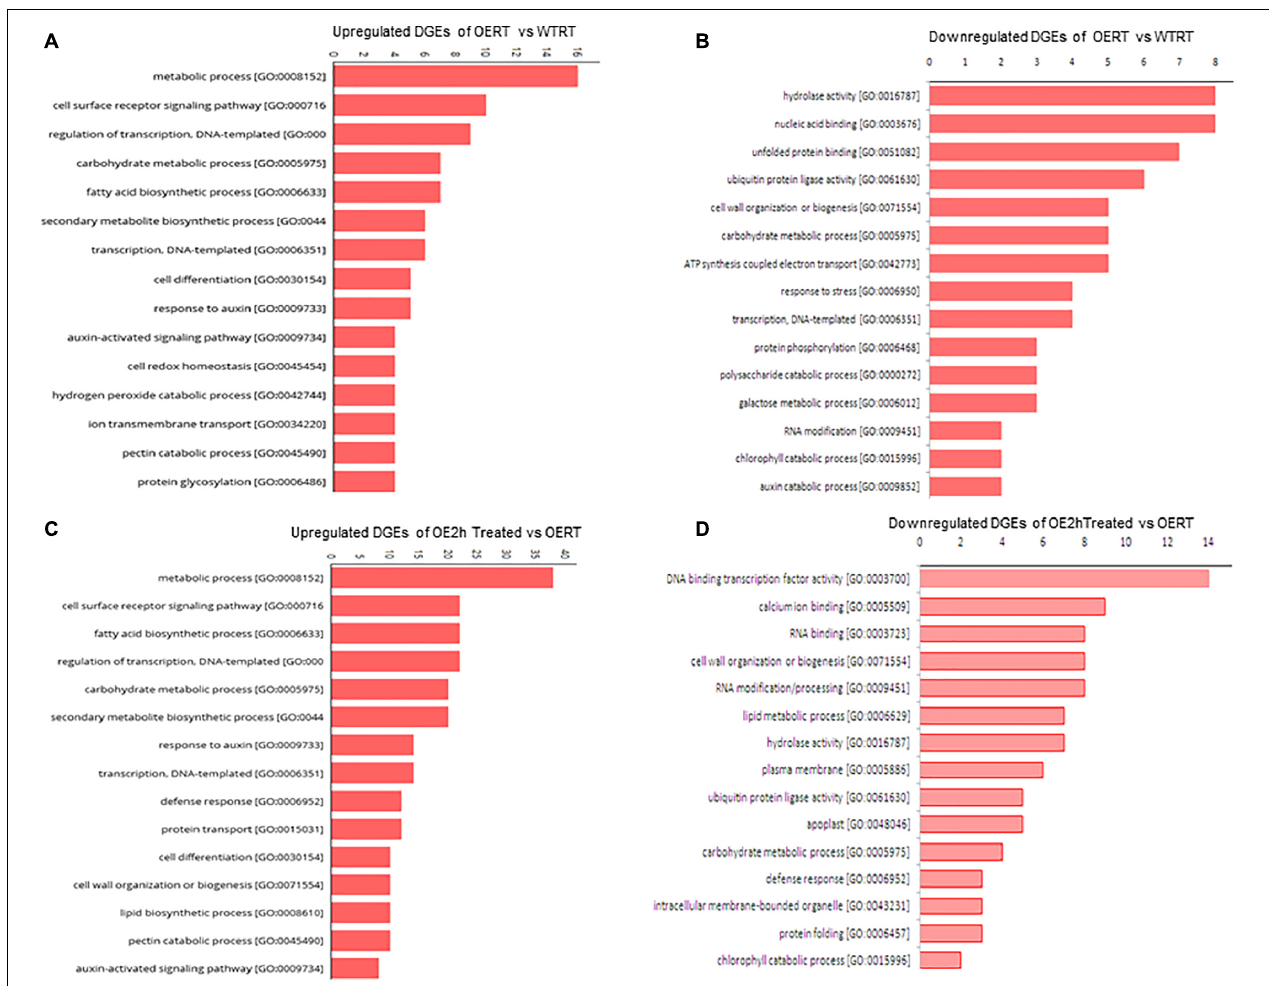
FIGURE 8 | Gene ontology (GO) classification of DEGs in SmHSP24.1 overexpressed OE and WT lines under control and stress conditions. (A,B) GO for both up- and down-regulated differentially expressed genes in SmHSP24.1 overexpressed OERT vs. WTRT lines under control environmental growth condition. (C,D) GO for both up- and down-regulated differentially expressed genes in SmHSP24.1overexpressed transgenic line under heat stress conditions. The y-axis and x-axis indicate the names of clusters and the gene number of each cluster respectively. Only the biological processes were used for GO term analysis. OERT: SmHSP24.1overexpressed line in room temperature, WTRT: WT line in room temperature, OE2h: SmHSP24.1overexpressed line under 2 h heat (45 ◦ C) stress